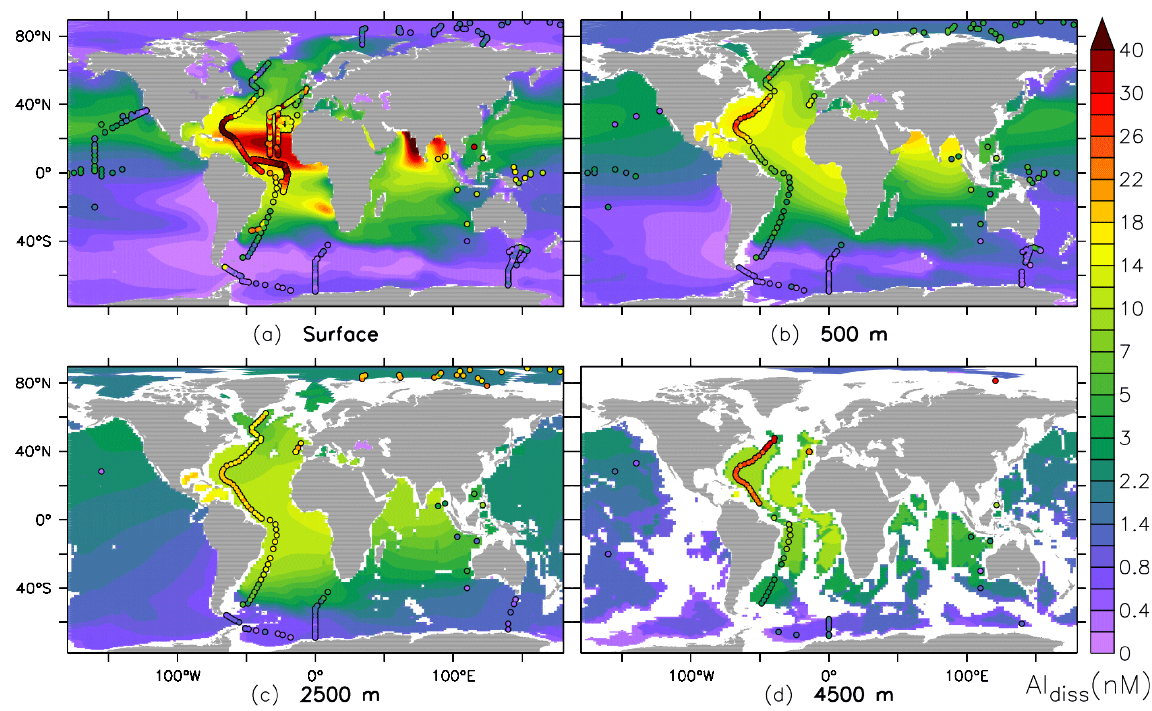
Figure 4. Average of the final model year (1750) of the dissolved aluminium concentration (nM) from the reference simulation (RefDyn2) at four depths. The respective observations (same depth ranges) are presented as coloured dots.